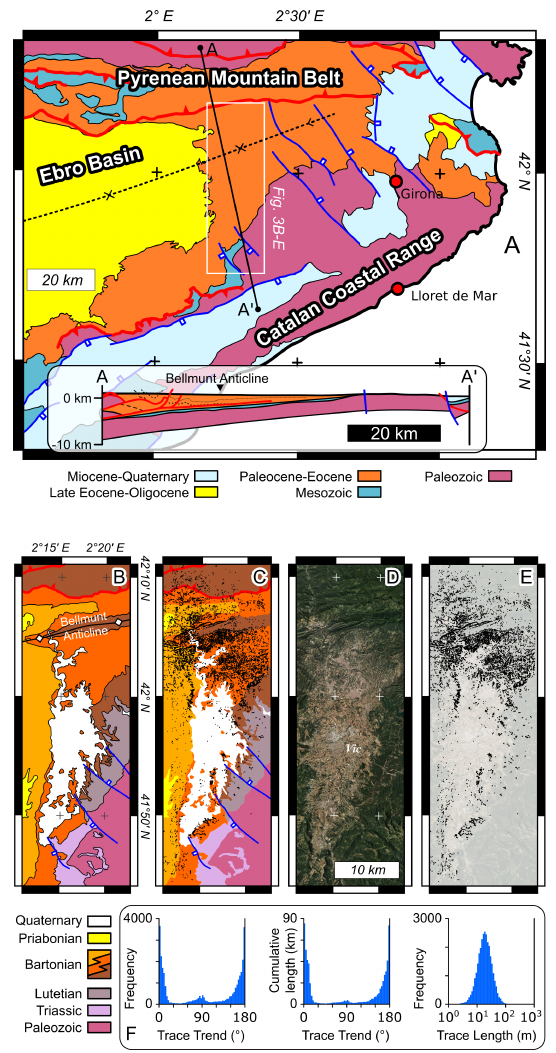
Figure 3. (a) Simplified geological map of the western Pyrenees and Catalan Coastal Range (based on the geological map of Catalo- nia scale 1:250000; https://www.icgc.cat/en/Downloads, last ac- cess: 1 July 2020) with the N–S geological cross section (modified from Parés et al., 1999). (b) Detailed geological map of the study area with digitized joints (c) . (d) Orthophoto (https://pnoa.ign.es/, last access: 1 July 2020) of the study area with digitized joints (e) . (f) Frequency distribution of joint traces trends and lengths.